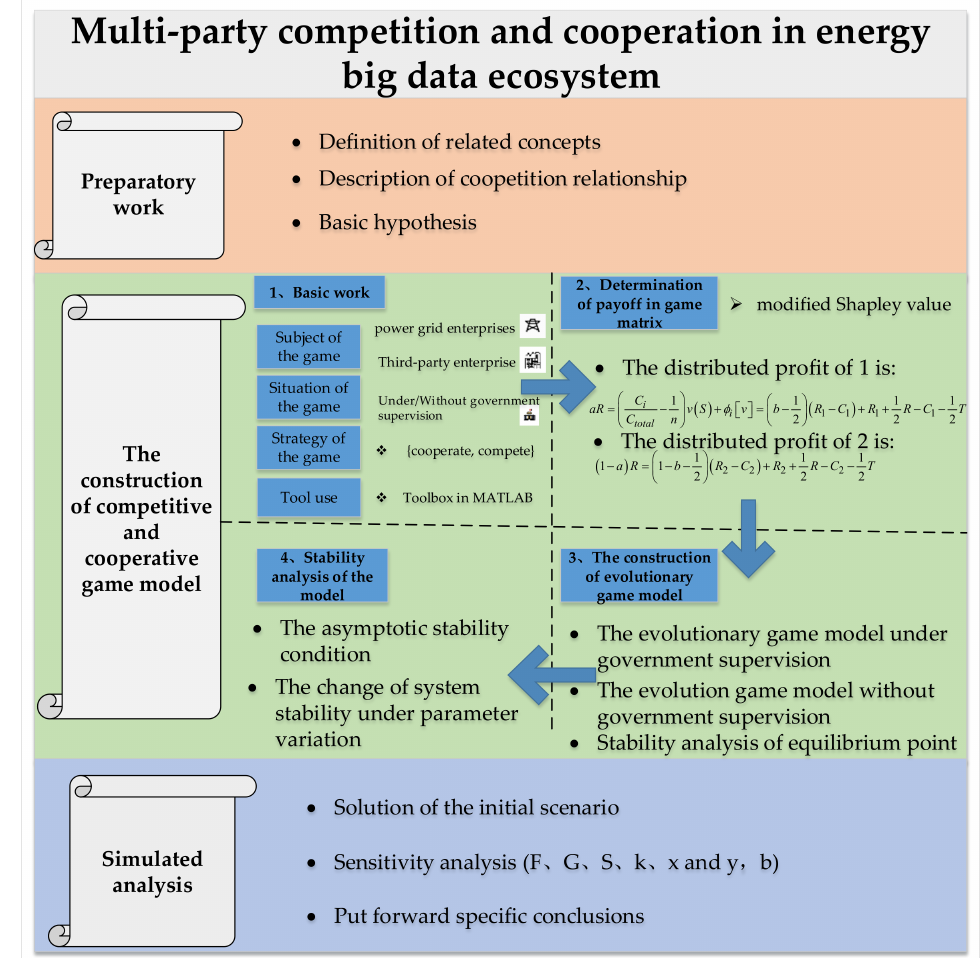
Figure 1. The roadmap of the model framework built in this